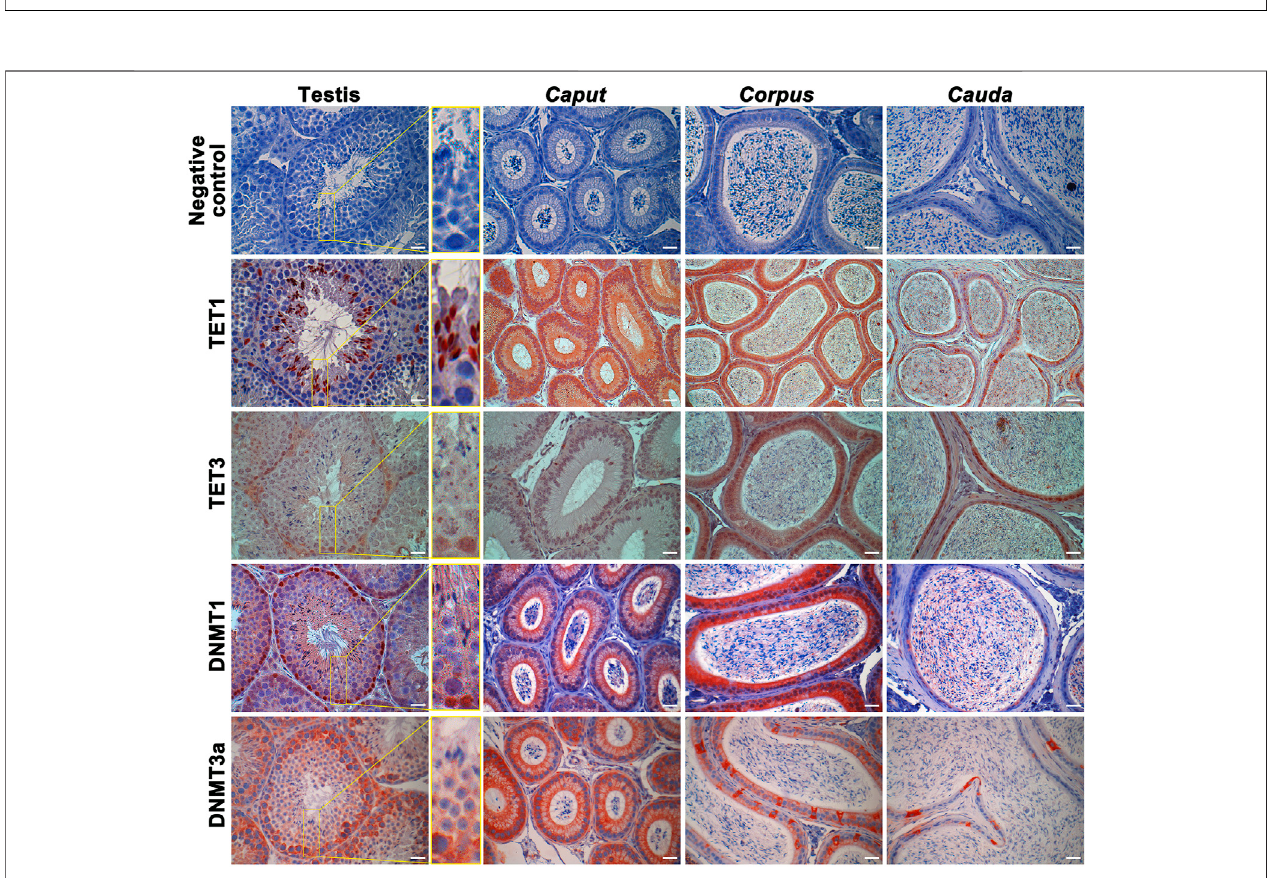
FIGURE 6 | Immunohistochemical detection of TET1, TET3, DNMT1, and DNMT3a in the testis, caput , corpus , and cauda epididymis. Omission of primary antibodies were used as a negative control. Results are representative of three independent experiments. Insets (yellow square) represent ×3 magni fi cation. Scale bar: 30 μ